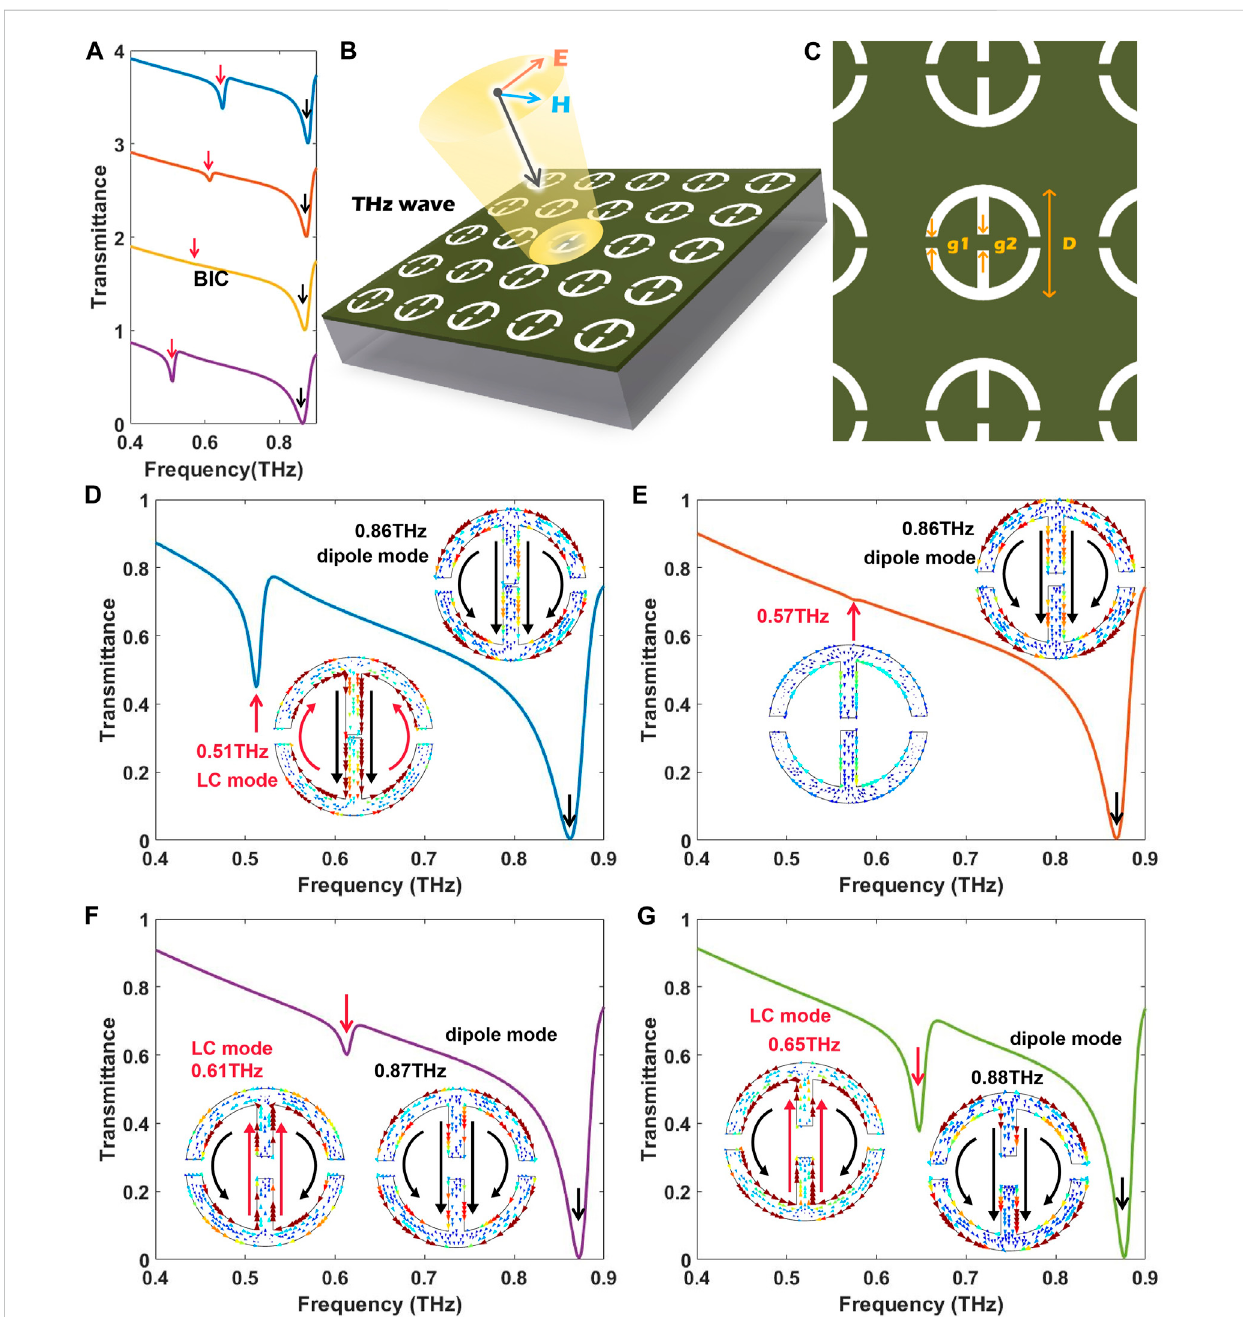
FIGURE 1 Illustration of the generation of BIC via coupled resonant modes, model design and measurement of transmission spectra. (A) The transmission coef fi cient for different frequency settings. The Q-factor is in fi nite in the BIC mode. (The red arrows label ω 1 and the black arrows label ω 2 .). (B) 3D schematic diagram of the metasurfaces. (C) Schematic of the metasurface design. The design dimensions are as follows: period p = 100 µm, the ring outerdiameter D =120 µm,width W =10 µm,doubleseamwidth g 1 =10 µm,controltheshiftof g 2 . (D) Theamplitudetransmissionspectrumofthe metasurface at g 2 = 2 µm under the Y polarization and the current distribution corresponding to the transmission valley. (E) The amplitude transmission spectrum of the metasurface of g 2 = 8 µm, and the current distribution corresponds to the transmission valley. (F) The amplitude transmission spectrum of the metasurface of g 2 = 14 µm, and the current distribution corresponds to the transmission valley. (G) The amplitude transmission spectrum of the metasurface at g 2 = 20 µm and the current distribution correspond to the transmission